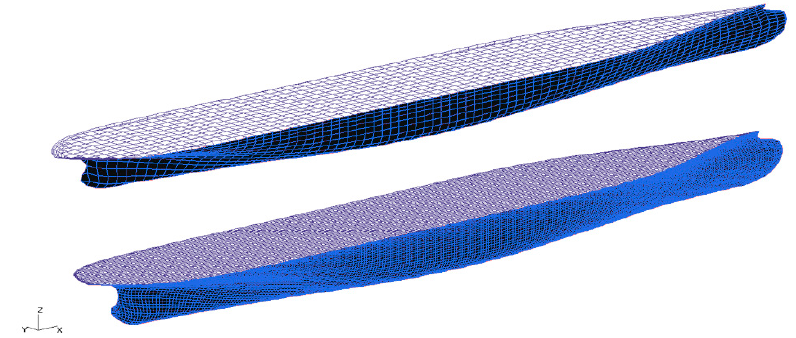
Figure 3. Panel models of KCS: coarse mesh (upper) and fine mesh (lower) [33].